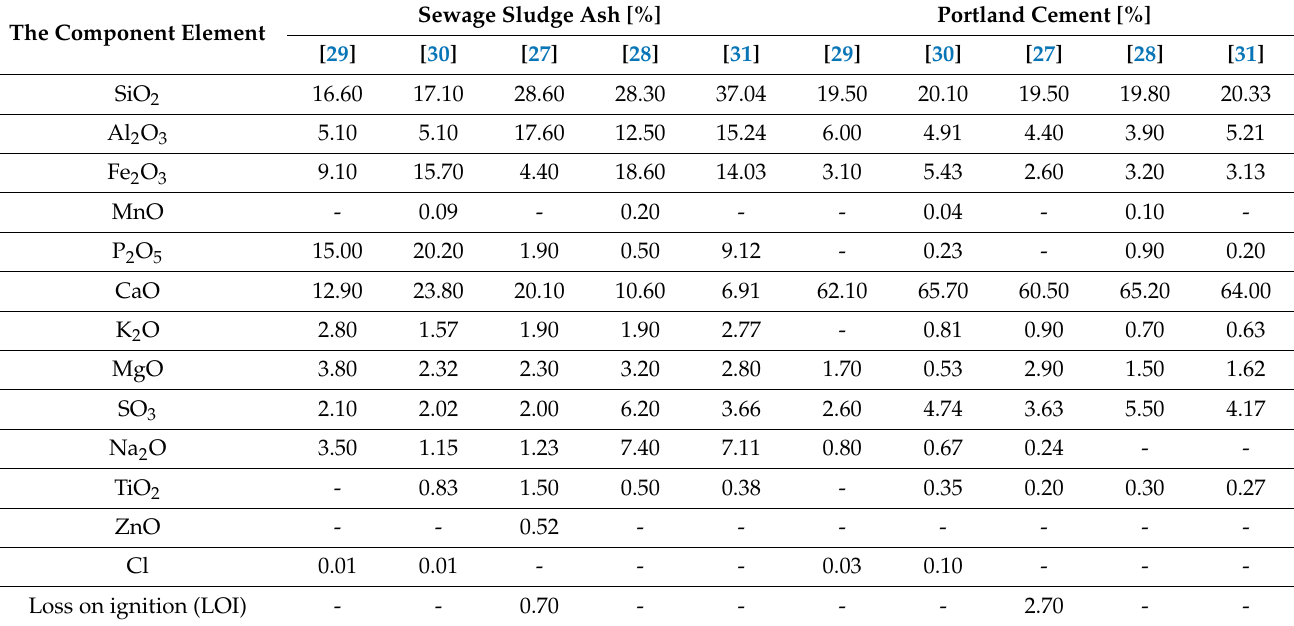
Table 2. Oxide content [27–31].